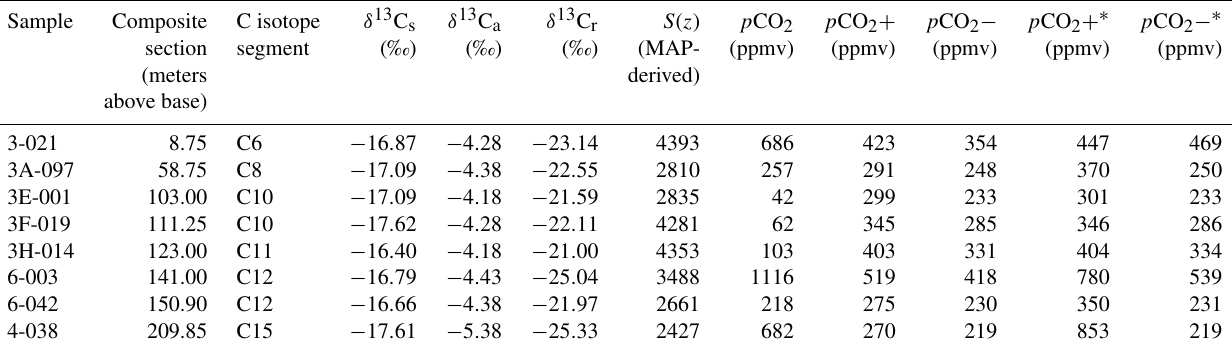
Table 4. Atmospheric p CO 2 calculated using δ 13 C s (from δ 13 C carb with temperature-dependent enrichment factor; Romanek et al., 1992; 2 σ uncertainty in δ 13 C carb and temperature propagated), δ 13 C a (average Atlantic bulk carbonate for C isotope segments following Bralower et al., 1999, with DIC atmosphere fractionation of − 8.23‰), δ 13 C r (organic C record of Suarez et al., 2018, with 2 σ analytical uncertainty (0.26‰) propagated), and S ( z ) (estimated from MAP following Cotton and Sheldon, 2012). p CO 2 + ∗ and p CO 2 − ∗ indicate the S ( z ) sensitivity test with the same 2 σ uncertainty and large S ( z ) range (see text for details). All δ 13 C values reported are relative to